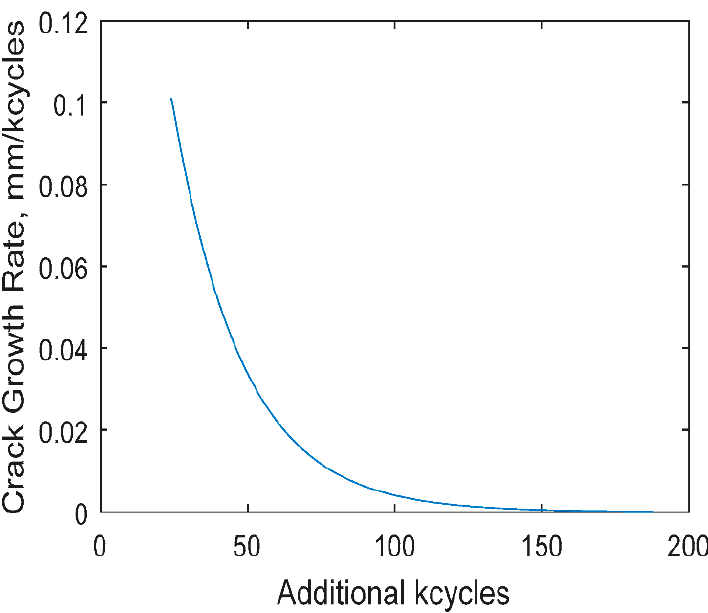
Figure 13. The crack growth rate calculated from the fatigue crack fitted curve.